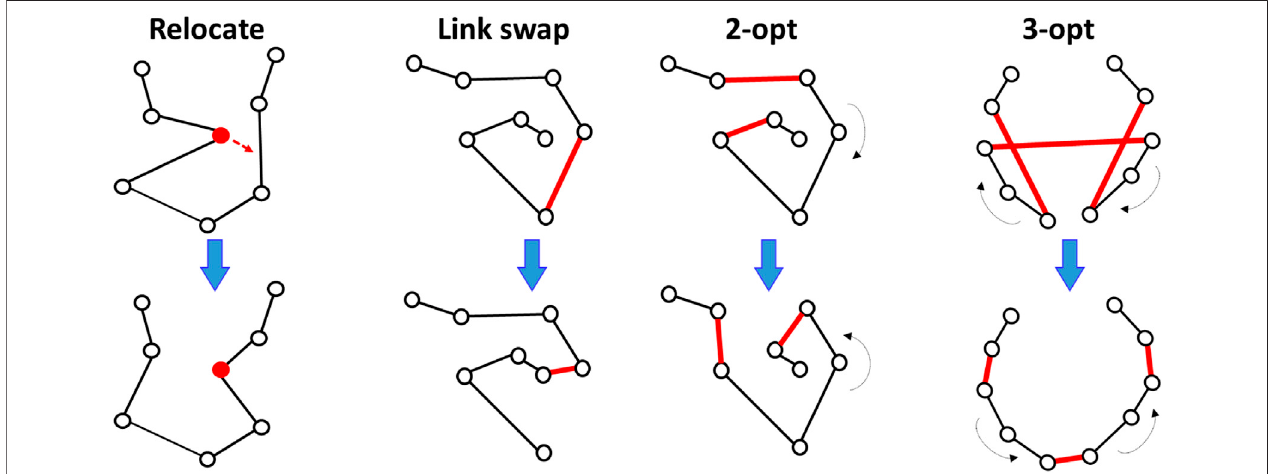
FIGURE 2 | Local search operators used in the submitted